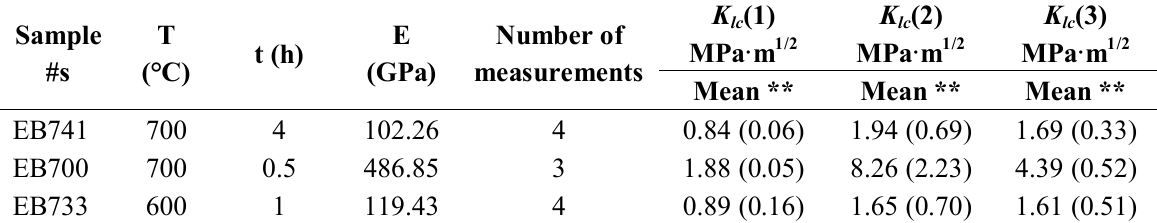
Table 4. Fracture toughness determinations of selected Ti Hardnesses and Young's moduli, E , were obtained from nanoindentation measurements on the same samples. Cracks used are from microindentations. Models (1) and (2) assume Palmqvist cracks, and model (3) assumes halfpenny cracks (see